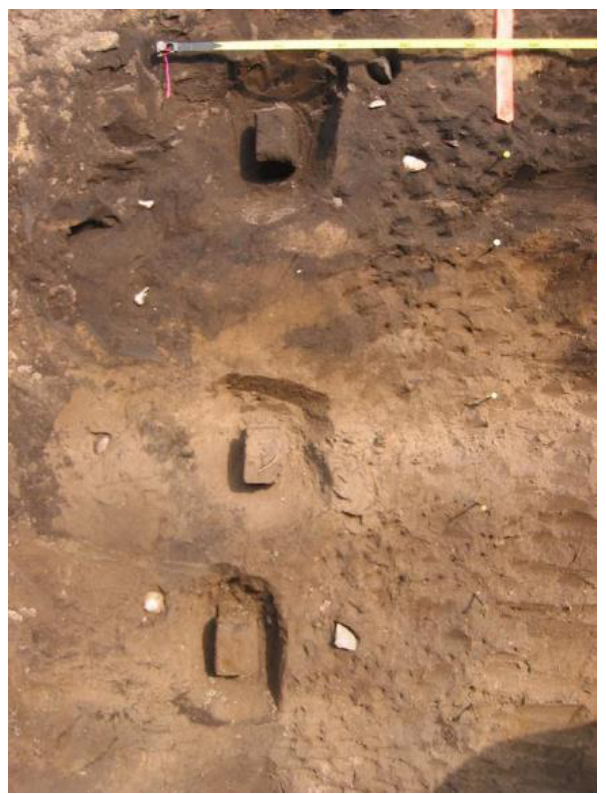
Figure 3. Artifacts within buried soil horizons at an archaeologi- cal excavation. The relationship between the soil horizons and ar- tifacts can provide archaeologists with important information. Pic- ture taken near Los Angeles, California, USA, courtesy of Jeffrey